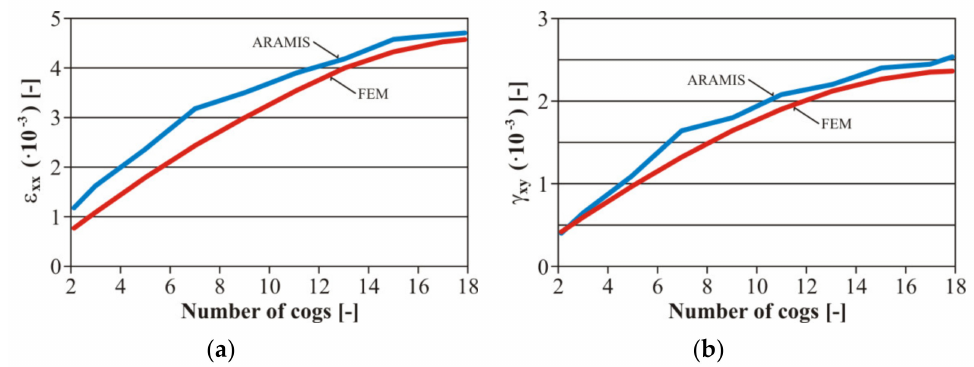
Figure 22. Comparing the determined deformations: ( a ) with the bending stress; ( b ) with the stress by